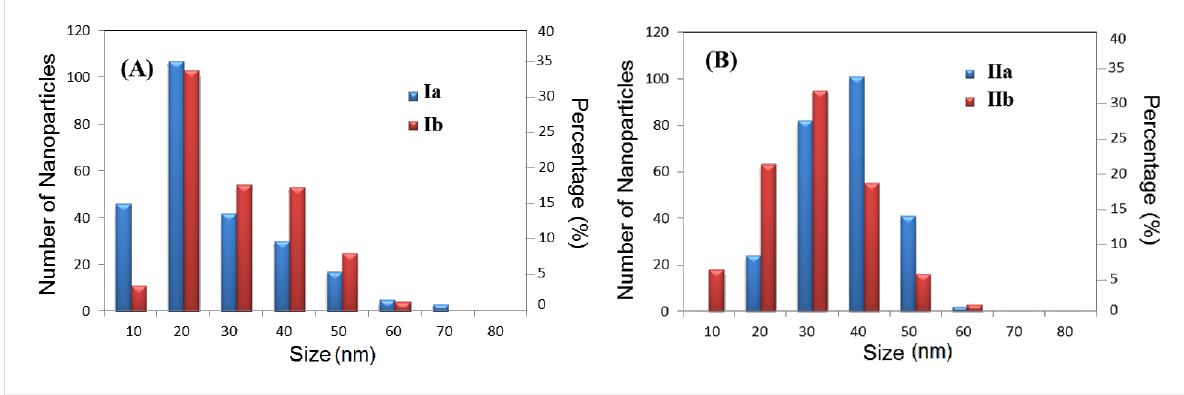
Figure 3: Size distributions of 250 nanoparticles of C 60 –androsterone (A) Ia,b and (B) IIa,b adsorbed on the TEM grids.